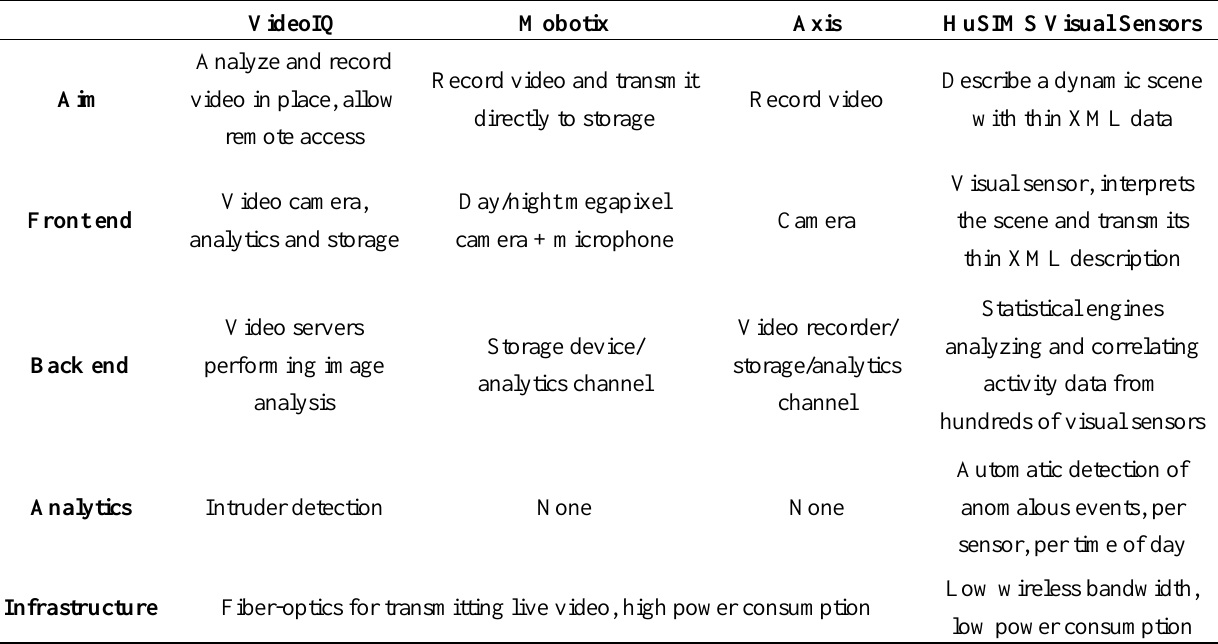
Table 1. Comparison of current video surveillance systems with the HuSIMS visual